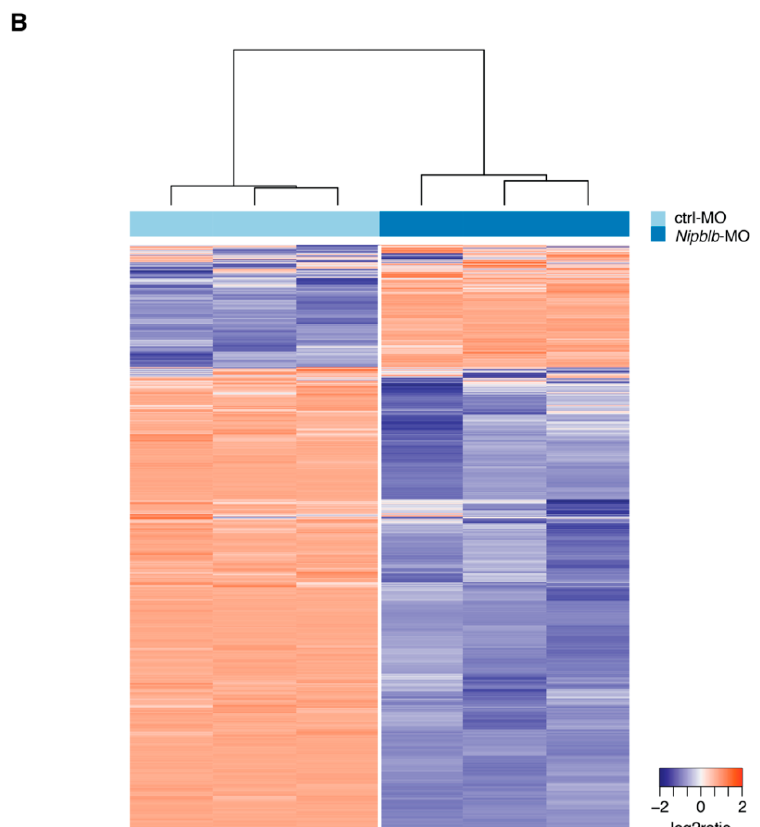
Figure 1. ( A ) Sample correlation matrix using gene-wise standardized expression values of 1922 highly variable genes. ( B ) Unsupervised hierarchical clustering of ctrl-MO and nipblb -MO-injected embryos at 24 hpf based on the standardized gene expression values of 1922 highly variable genes. Each column represents one separated biological sample.